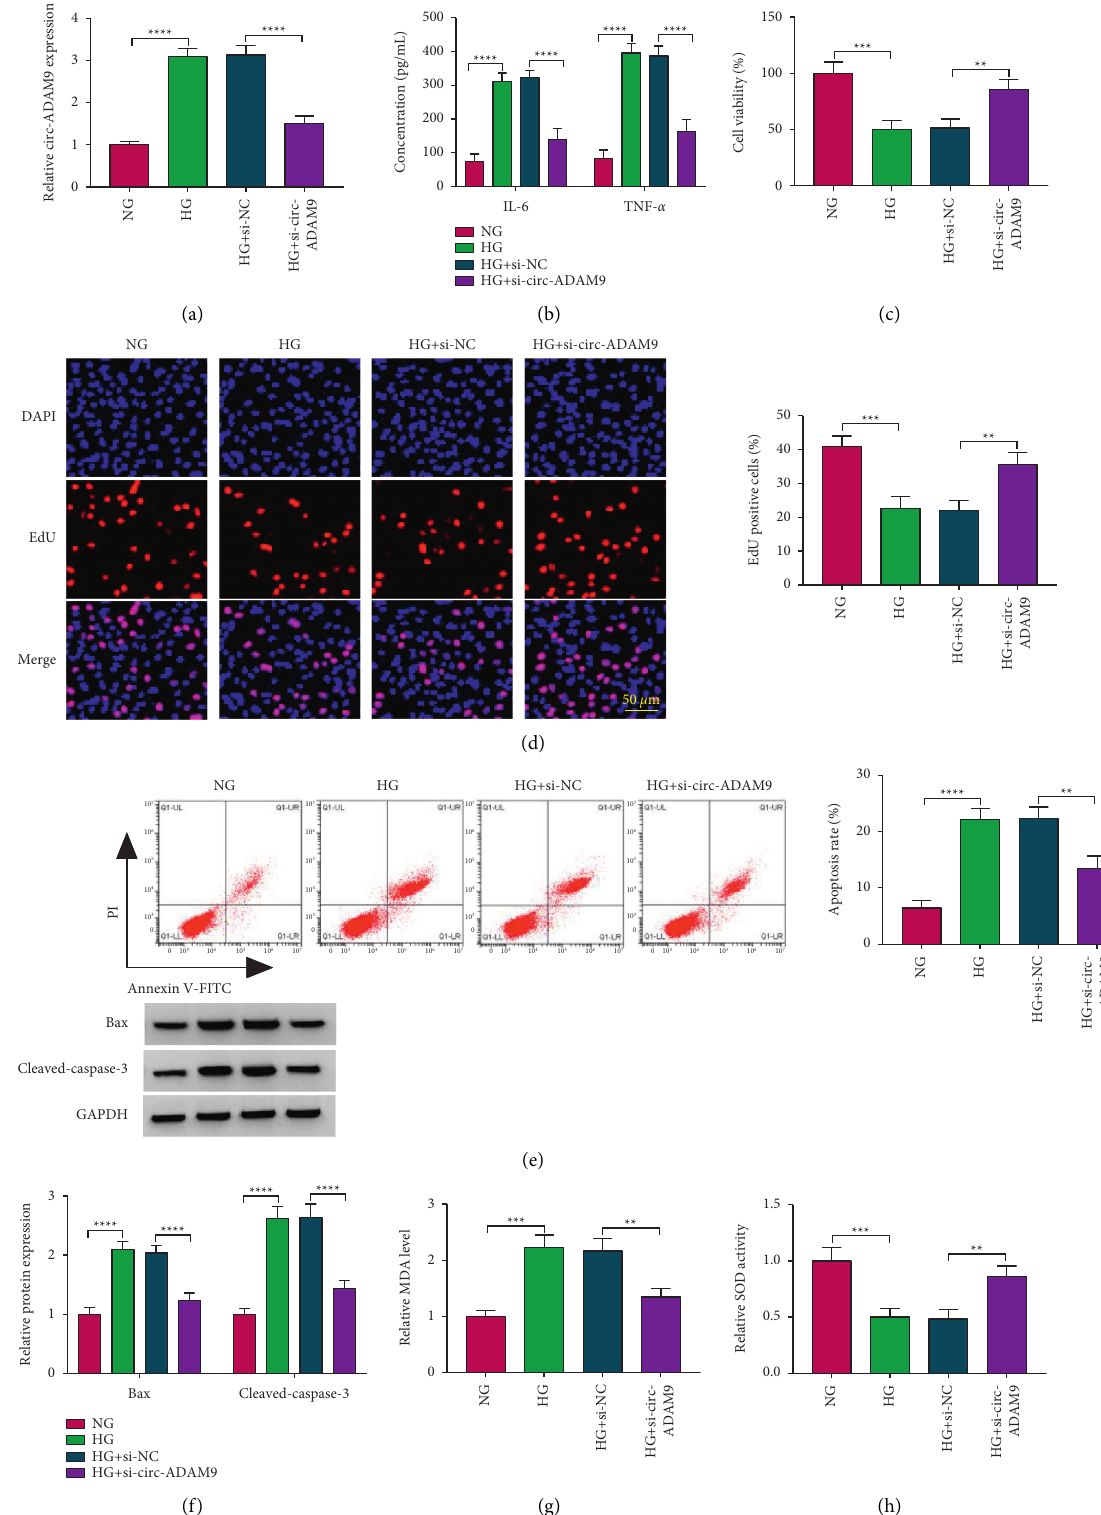
Figure 2: Effects of si-circ-ADAM9 on HG-induced ARPE-19 cell injury. ARPE-19 cells were transfected with si-NC or si-circ-ADAM9 and then treated with HG. The cells treated with NG were used as control. (a) The expression of circ-ADAM9 was measured by qRT-PCR. (b) ELISA was utilized to detect the concentrations of IL-6 and TNF- α . MTTassay (c), EdU assay (d), and flow cytometry (e) were determined to measure cell proliferation and apoptosis. (f) The protein expression of Bax and cleaved-caspase-3 was detected by the WB analysis. (g, h) MDA level and SOD activity were examined to assess cell oxidative stress. ∗∗ P < 0 . 01, ∗∗∗ P < 0 . 001, and ∗∗∗∗ P < 0 .